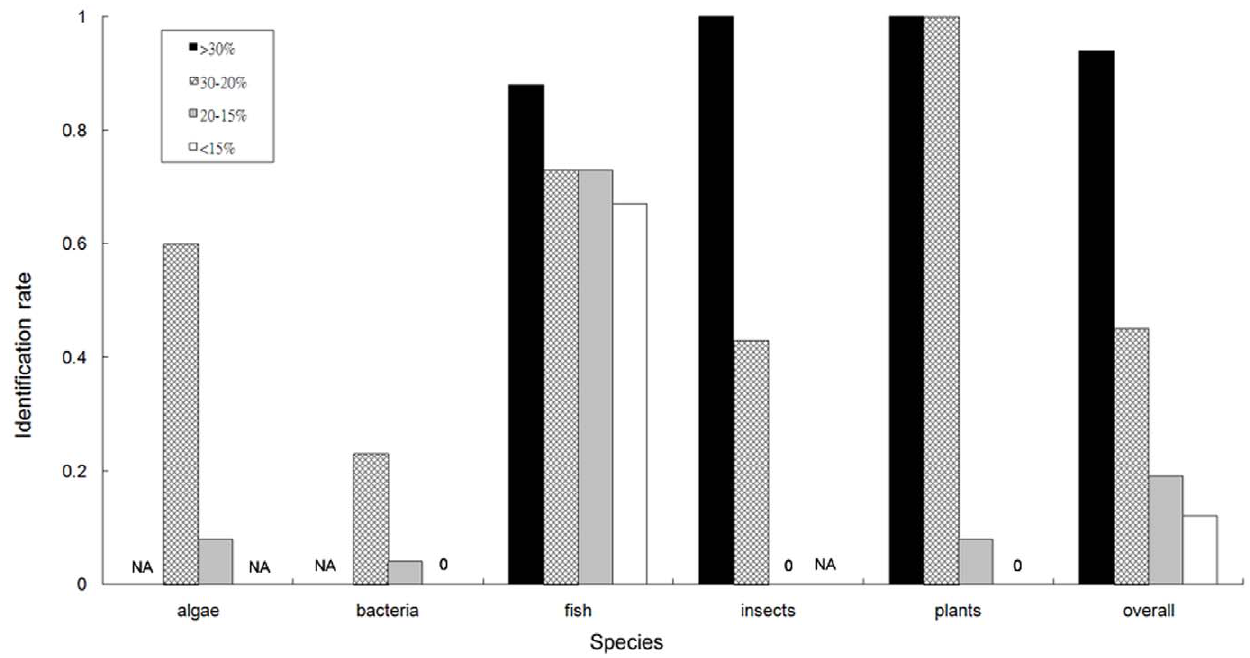
Figure 4. Rate of identifying the 369 AFPs from the second independent set. Each bar correlates the identification accuracy with a range of maximum SI values, found from the y axis of Figure 1 in specific ranges of SI for the different